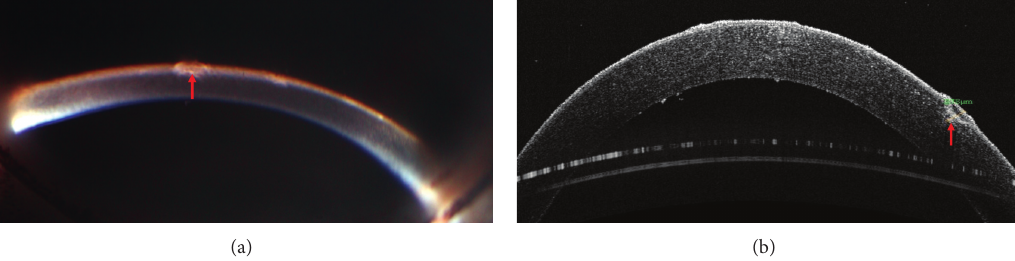
Figure 3: (a) Slit lamp examination suggests that the opacity is limited to the epithelium. (b) OCT examination reveals the presence of significant sub-Bowman’s scarring measured to a depth of 278 𝜇 m. The arrow indicates the location of opacities.